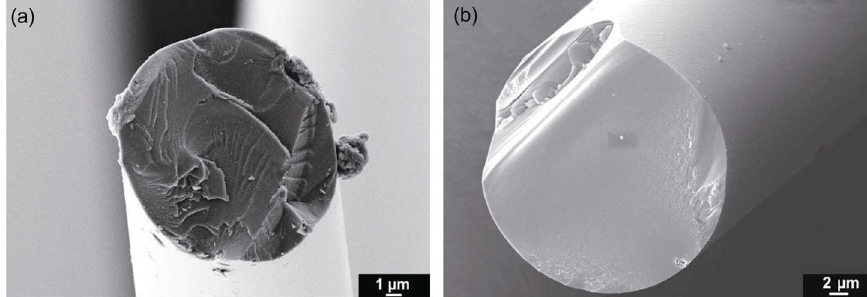
Fig. 10 Fracture surface of typical ceramic fibers derived from preceramic polymers: (a) Hi-Nicalon; (b) ABSE-derived SiCN fiber. Reproduced with permission from Ref. [86], © WILEY-VCH Verlag GmbH & Co. KGaA, Weinheim